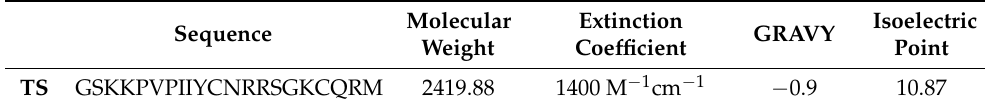
Table 2. Basic properties of antimicrobial peptide